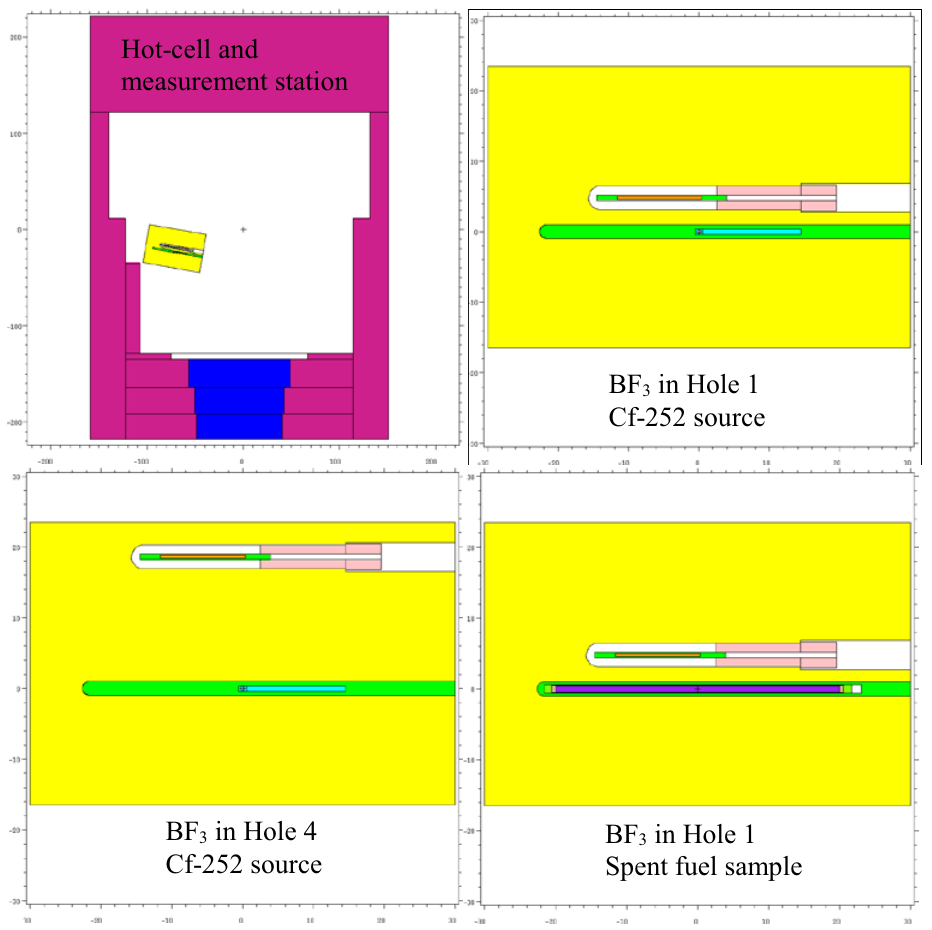
Figure 2. Horizontal cutaway views of the MCNP model of selected measurement set-ups – distances in